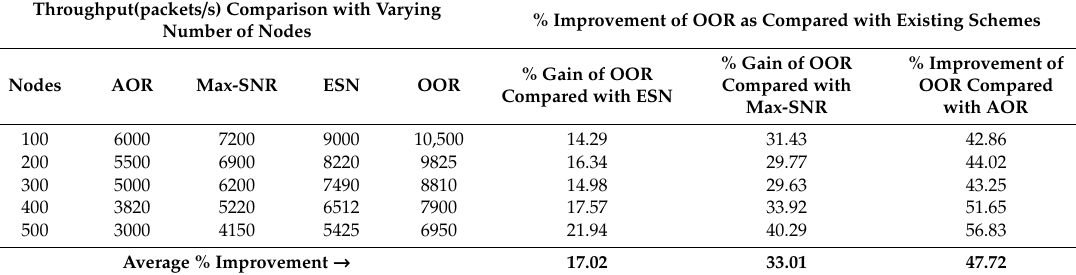
Table 3. Descriptive observations of OOR performance in terms of